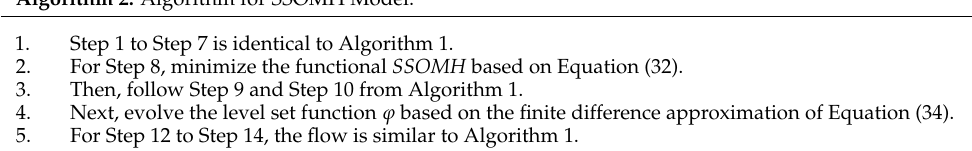
Algorithm 2: Algorithm for SSOMH